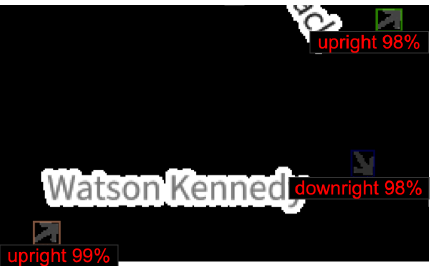
Figure 15. Arrow direction detection for